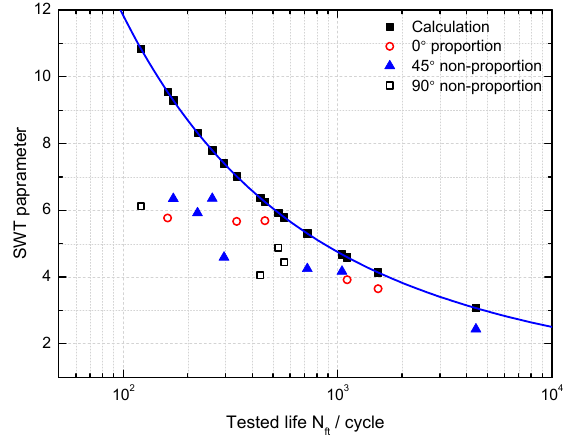
Figure 2. Smith-Watson-Topper (SWT) parameter vs. N ft correlation for GH4169 at 650 ◦ C.